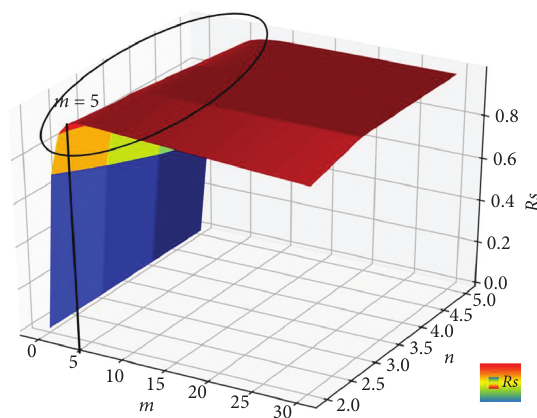
Figure 7: Reliability curve of parallel-series system as a function of parameter m .